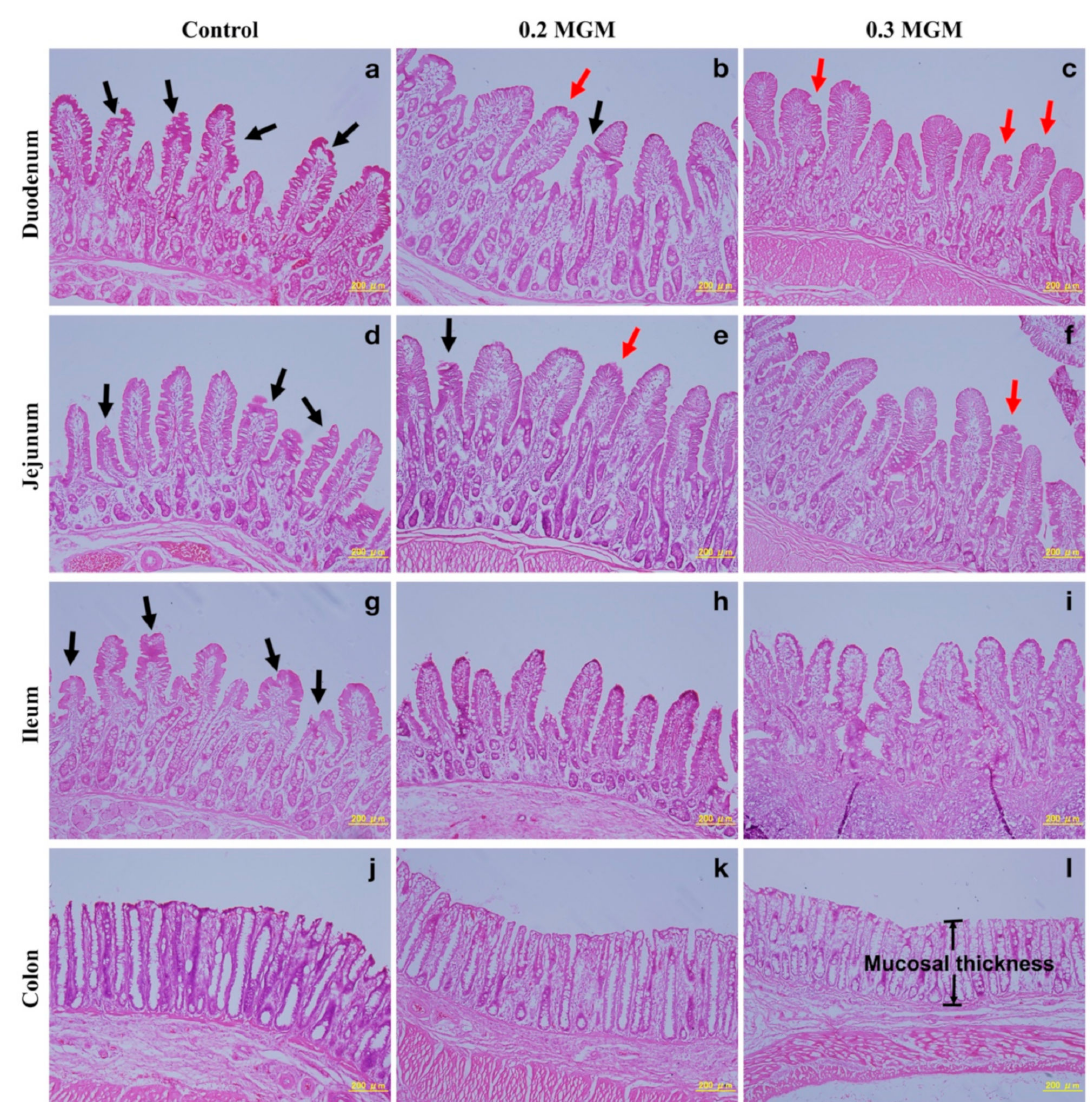
Figure 6. Representative histological micrographs of the duodenum, jejunum, ileum, and colon weaned piglets at 20 days post-weaning, produced by hematoxylin and eosin staining. Scale bar, 200 µ m. Abbreviations: Control, control group; 0.2 MGM, 0.2% MGM-P group; 0.3 MGM, 0.3% MGM-P group. Pathological changes at the tips of intestinal villi during weaning are indicated by red (slight damage) and black (serious damage) arrows. The exposed lamina propria are clearly visible in the control group ( a , d , g ). The mucosal integrity is relatively high in the treatment group ( b , c , e , f , h , i ) especially in 0.3 MGM group ( f , h , i ). The mucosal thickness of the colon is relatively thick in the control group ( j ) and 0.2 MGM group ( k ) than that in the 0.3 MGM group ( l ) (including the muscularis